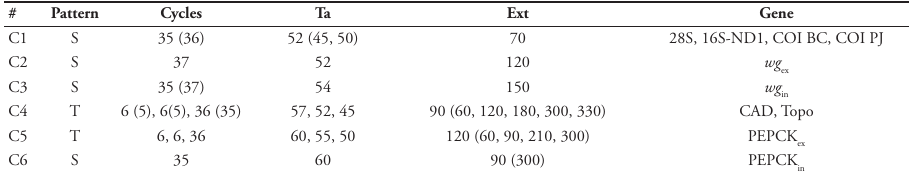
PCR thermal cycling conditions for recommended protocols. The Pattern column indicates cycling pat- tern. “S”, for standard reaction pattern, included a starting phase of 2 or 3 minutes at 94 °C, followed by the cycling phase, with each cycle consisting of 20–30 seconds of denaturing at 94 °C, 20–30 seconds of annealing at the annealing temperature, and an extension phase at the temperature specified by the Taq manufacturer. “T”, for touchdown reaction, is like the standard reaction but with three cycling phases, each with a separate annealing temperature. The Cycles column lists the usual number of cycles, with all variant numbers used successfully to generate at least one sequence given in parentheses. For touchdown reactions, the numbers are given for each cycling phase, separated by commas. The Ta column lists the usu- al annealing temperature in °C (with less used but successful temperatures in parentheses). For touchdown reactions, the annealing temperatures are given for each cycling phase, separated by commas. The Ext column lists the duration of the extension phase in seconds, with less used but successful durations in pa- rentheses. The Gene column lists the gene(s) successfully amplified with each set of conditions. Subscripts “ex” and “in” refer to conditions used for outer and inner nested (or hemi-nested reactions),